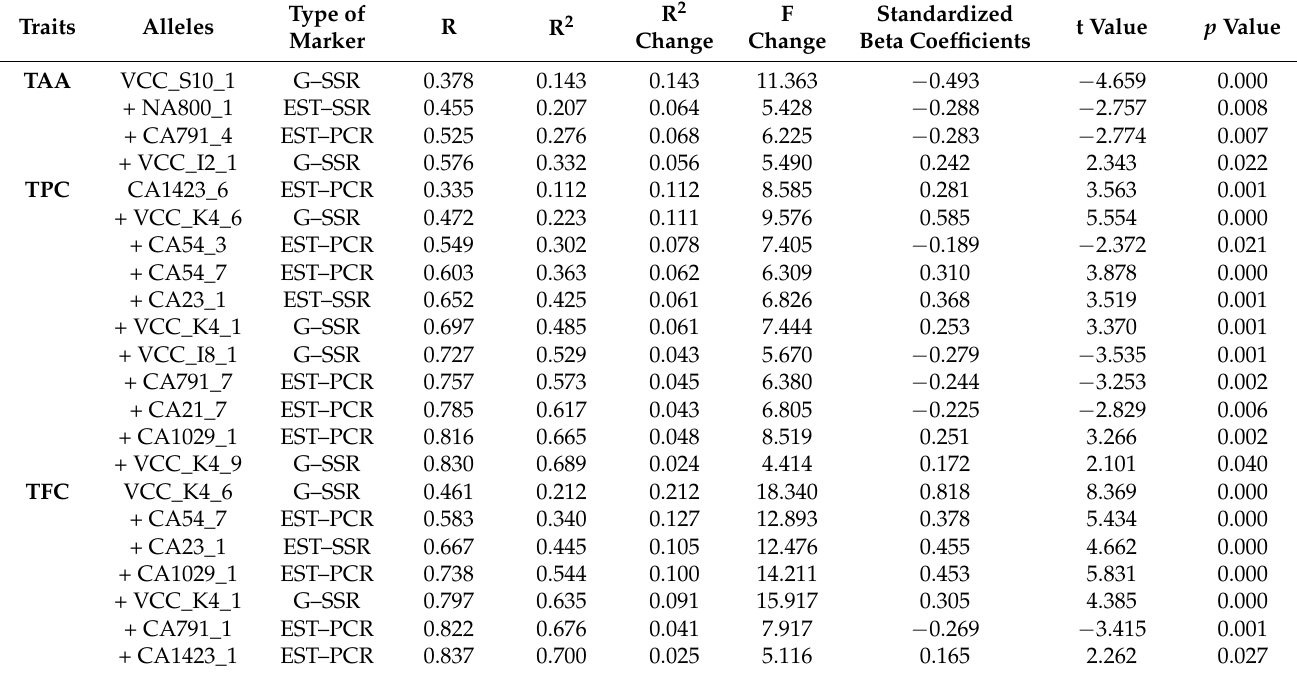
Table 7. Association of EST–SSR, G–SSR and EST–PCR markers with biochemical components in blueberry leaf extract, as revealed by stepwise multiple regression analysis